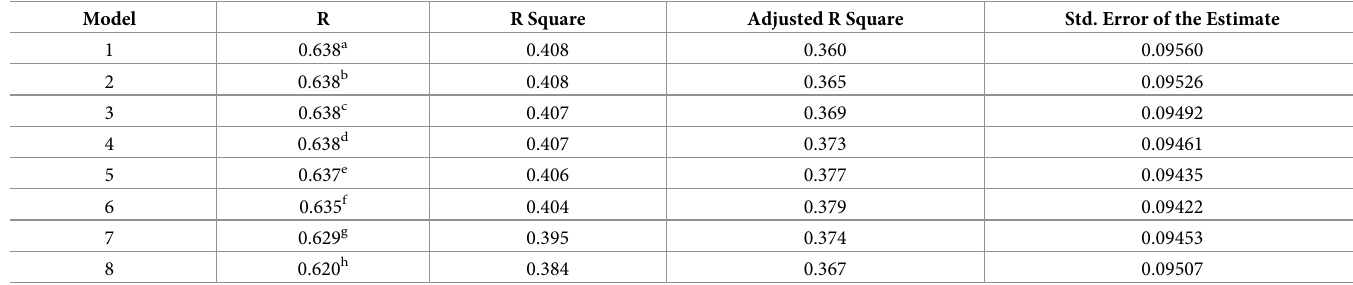
Table 6. Model summary. Testing hypothesis H4.